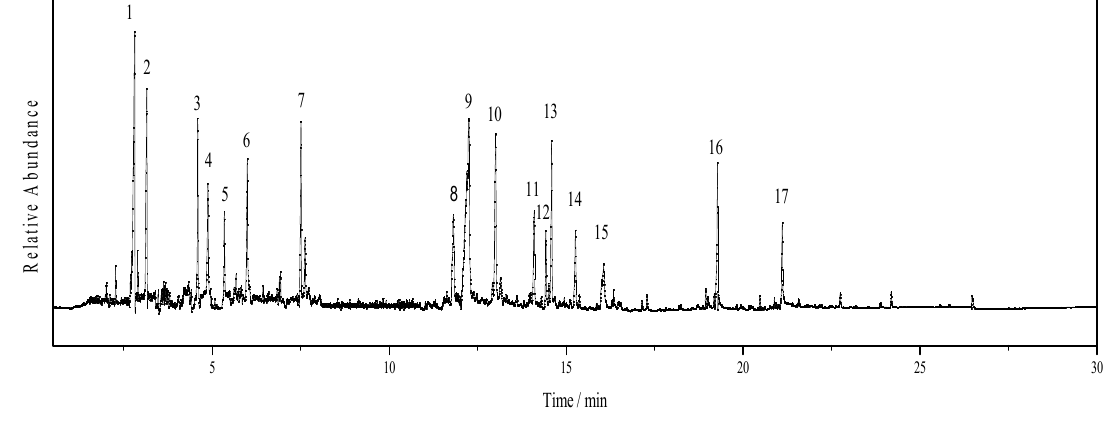
Figure 6. GC-MS diagram of bio-oil.